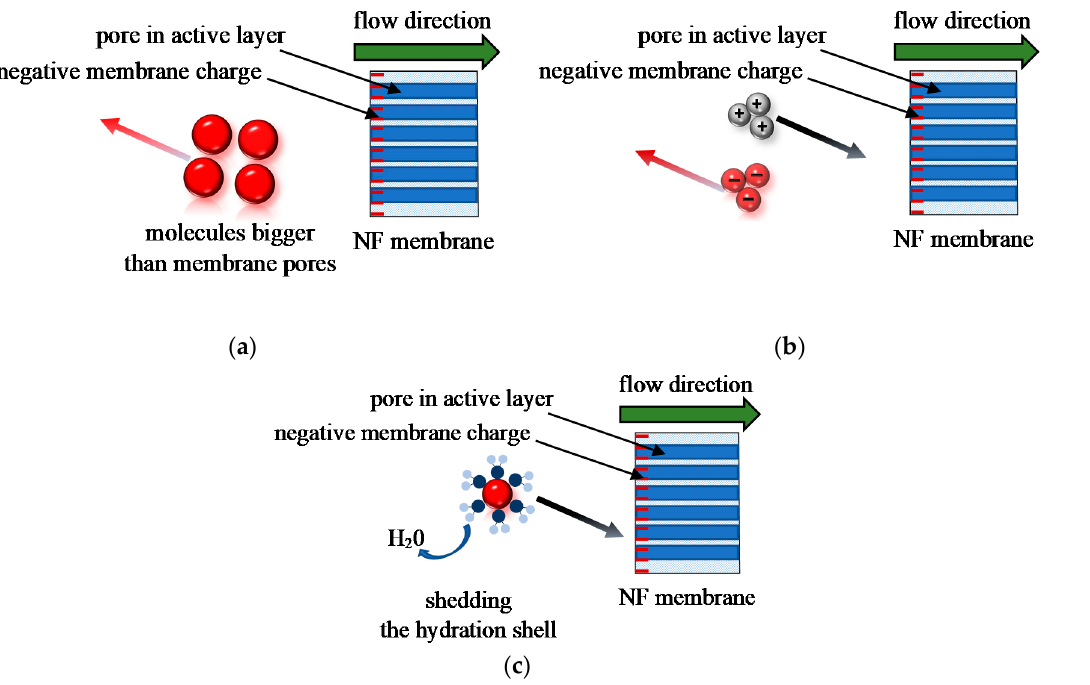
Figure 1. Mechanisms of solute separation in NF: ( a ) Steric exclusion; ( b ) Donnan exclusion; ( c ) Dielectric exclusion.